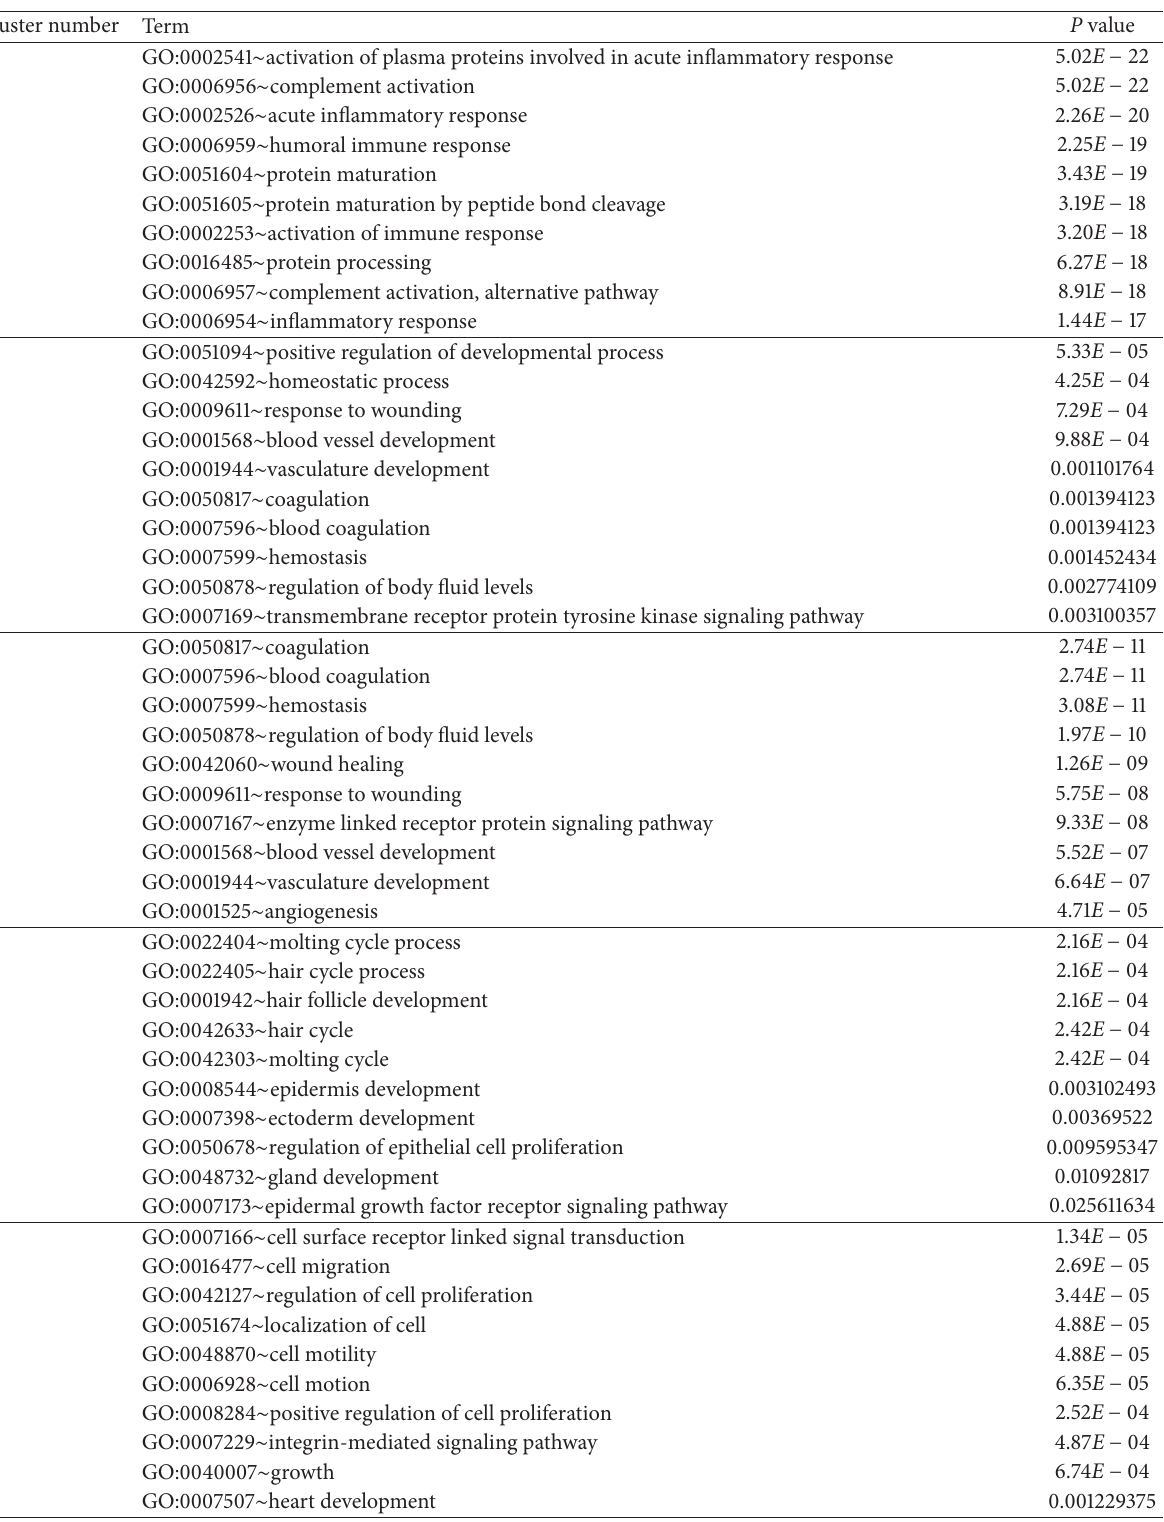
Table 5: Enrichment of GO terms for BvL579, BvM501, and LvM442 cluster